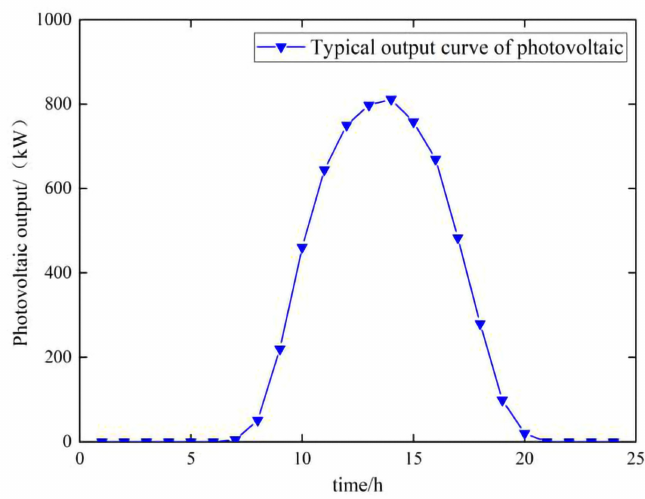
The typical daily load curve in this area is shown in Figure 9.